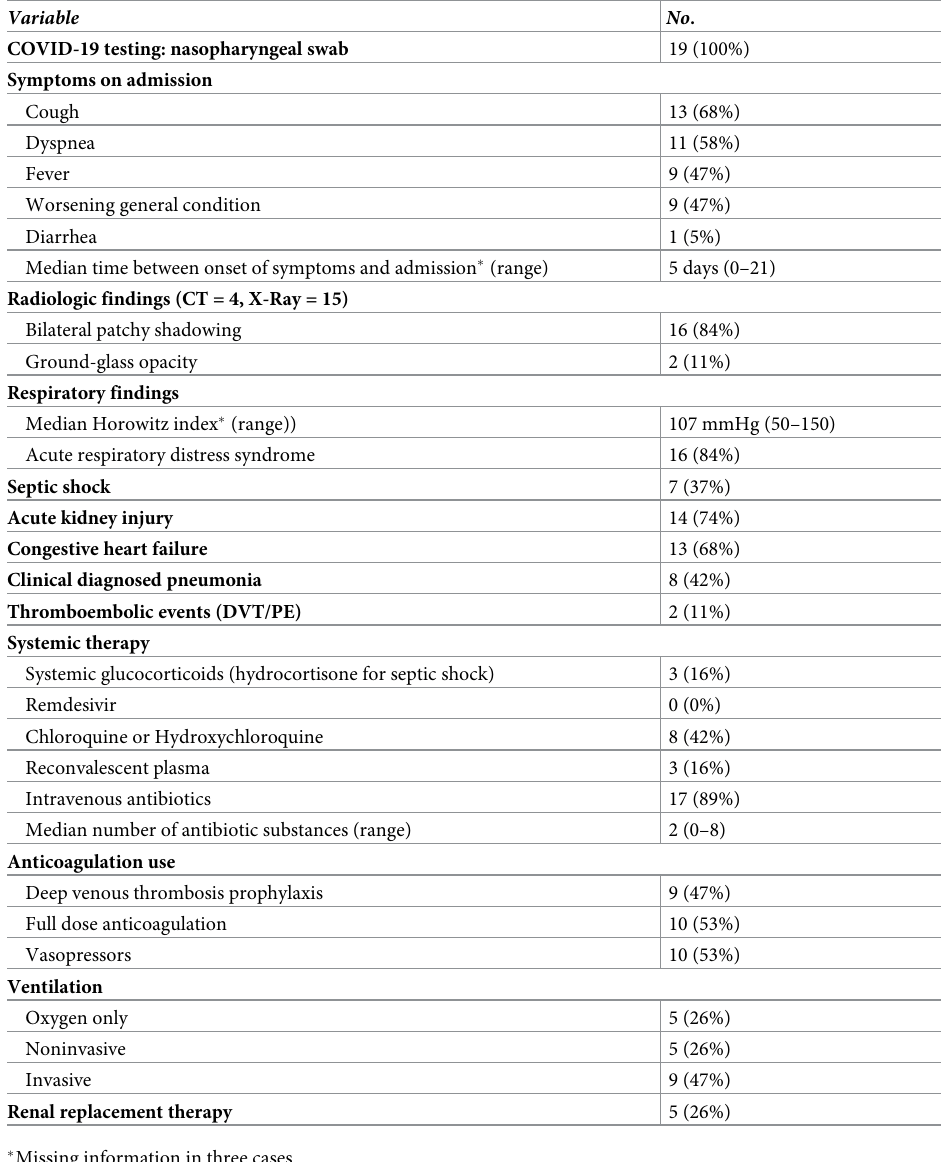
Table 2. Clinical course and